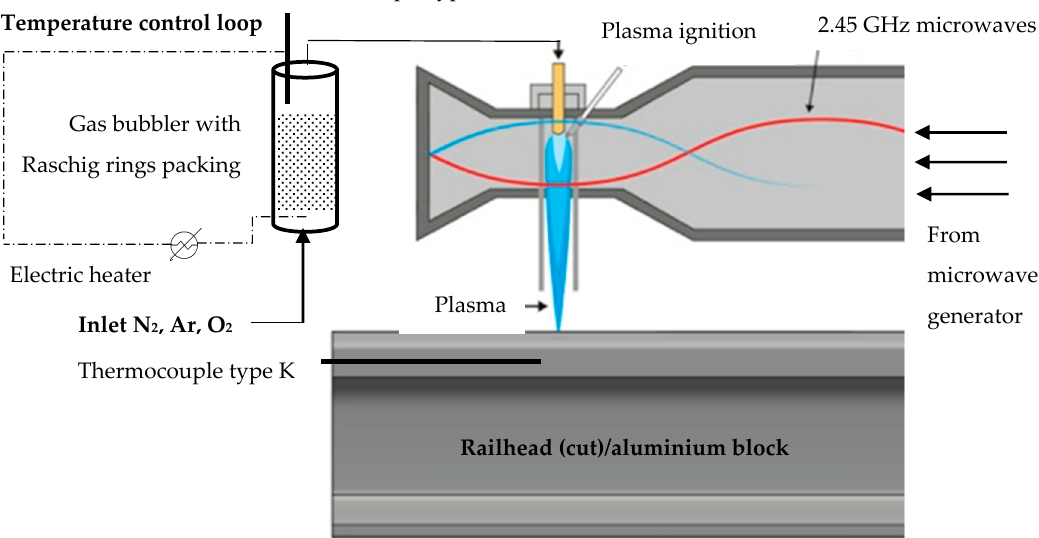
Figure 3. Schematics of the microwave plasma directed onto the railhead (red—microwave forward power, blue—microwave reflected power).